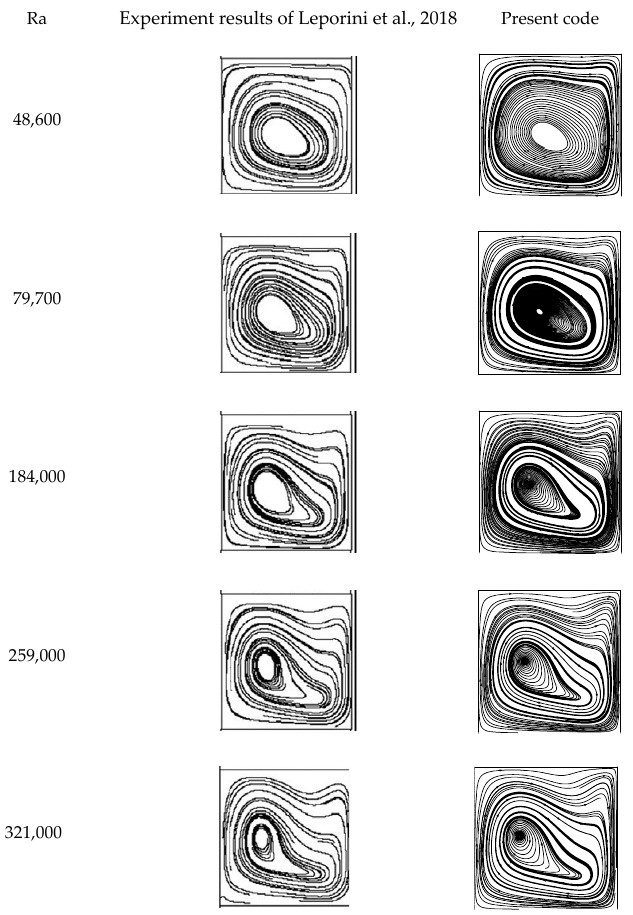
Figure 4. Validation of the present numerical method with the experimental results of Leporini et al. [38]. Figure 5 presents the distribution of the temperature iso-surfaces as well as the tra- jectory of the particles for different Rayleigh numbers. In the case when the heat source centered at the bottom of the plane (x = 1, case 1) is considered for Ra = 10 3 , a significant thermal diffusion towards the middle of the chamber was noted. A horizontal and orthog- onal thermal stratification at the heat source takes place. The ventilation velocity (at the suction and extraction) is relatively low and the birth of a small eccentric cell at the top near the x = 0 plane is observed. By increasing Ra to 10 4 the horizontal warm air layer, propagation decreases, the ventilation at the exhaust and suction windows accelerate, the size of the cell becomes larger and occupies the entire middle of the enclosure. It should also be mentioned that the presence of the table as an obstacle does not seem to disturb the flow for low Rayleigh numbers. For Ra = 10 5 , a strong upward flow of warm air occurs just above the source. The isothermal surfaces show a strong temperature gradient located above the source. This gradient helps the thermal buoyancy forces to dominate the viscous ones, which explains the observed ascending air movement. When a large value of Rayleigh number is reached (5 × 10 5 or 10 6 ), the table interferes with the flow and a strong vortex activity is noted on the whole left edge of the table. It is also noted that the thermal buoyancy forces generate a strong movement just overhead of the heat source preventing the warm air layers to be blown into the center of the chamber. In this configuration and regardless the Rayleigh number, the main ventilation flow is along the floor (y = 0) and then up the wall equipped with the heat source (x = 1). Finally, it is important to point out that there is a transition from a horizontal strati- fication starting from the heat source at Ra = 10 3 to a vertical stratification starting from the roof for Ra = 10 6 . For the second case (Figure 6), where the heat source is moved to the wall containing the suction window (x = 0, case 2), the behavior of the flow has completely changed. In- deed, we note that the main ventilation flow goes up directly to the top of the chamber as soon as it leaves the suction window (x = 0). Then the airflow drifts towards the extraction window, following the ceiling. The flow observed in the first configuration, i.e., the circu- lation at ground level then climbing up the wall (y = 1) until the suction window still coexists for low Rayleigh number. Moreover, for small Rayleigh numbers, a lateral infil- tration of the warm air layer towards the center of the room is achieved while for high Rayleigh numbers, this infiltration is carried out vertically just above the heat source and then a strong thermal gradient is established in this region. In fact, from Ra = 10 5 , the ther- mal buoyancy forces take the control of the ventilation and impose the air circulation in the chamber. The obstacle effect is only felt for very high Rayleigh numbers. For instance, at Ra = 10 6 , the table imposes a kind of compartmentalization, and a reversed air circulation is observed below and above it.